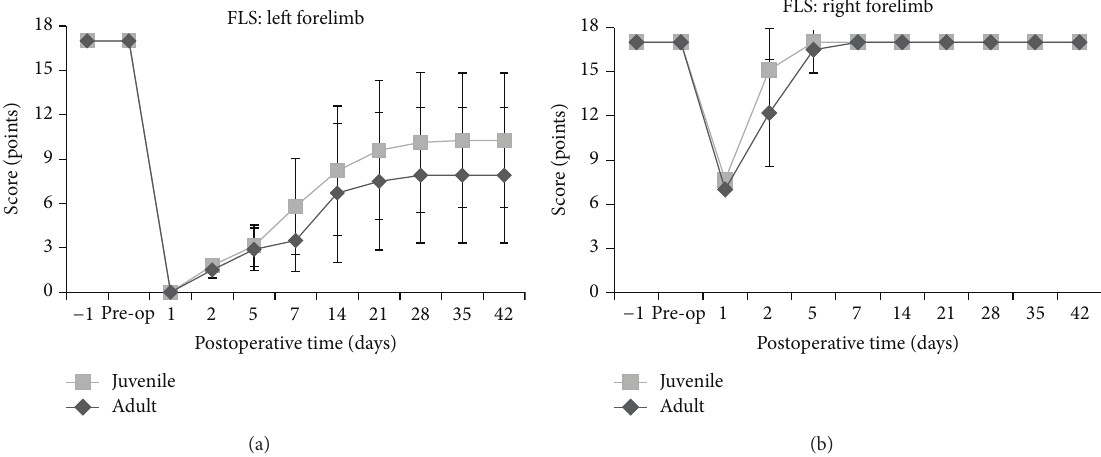
Figure 7: Forelimb Locomotor Scale (FLS) scores in juvenile and adult rats. The FLS of the left and right forelimb shows that no significant difference was noticeable between juvenile and adult